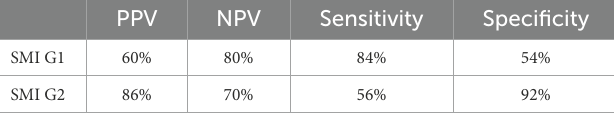
PPV, Positive predictive value; NPV, negative predictive